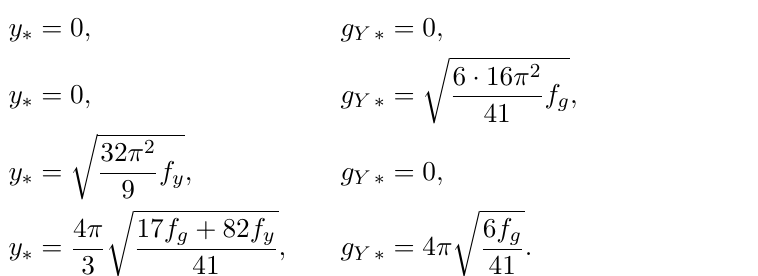
Figure 8 . We show contour lines in the b , G plane for a = 0, where the (cid:12)xed-point value of y is given by 0.1 (cyan, dotted), 0.3 (cyan, dot-dashed), 0.5 (cyan, dashed) and 0.7 (cyan, continuous), and contours where the (cid:12)xed-point value of g Y is given by 0.1 (green, dotted), 0.3 (green, dot-dashed), 0.5 (green, dashed) and 0.7 (green, continuous). Both are evaluated at the fully-interacting (cid:12)xed point (5.12), i.e., the values for the y -contours holds for (cid:12)nite values of g Y . negative